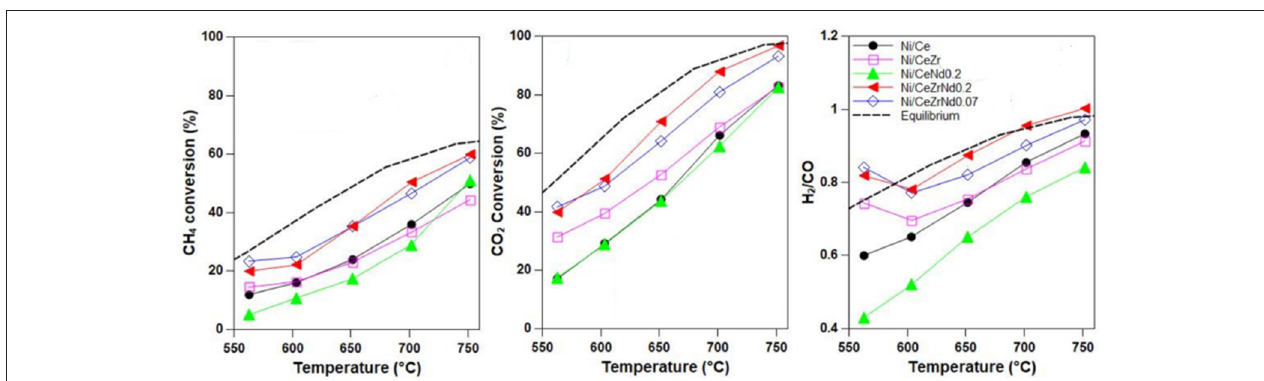
FIGURE 7 | Methane dry reforming activity of Ni catalysts prepared by wet impregnation of supports of CeO 2 , CeO 2 doped with Nd or Zr and of CeO 2 co-doped with Zr and Nd. (GHSW = 8,000 h − 1 , CH 4 /CO = 1.5). It was possible to obtain an improvement of ceria MDR activity only by co-doping, which affects both redox and acic-basic properties of support. Adapted from Pappacena et al. (2018), “Open Access” and licensed by the respective authors in accordance with the Creative Commons Attribution (CC-BY) license.